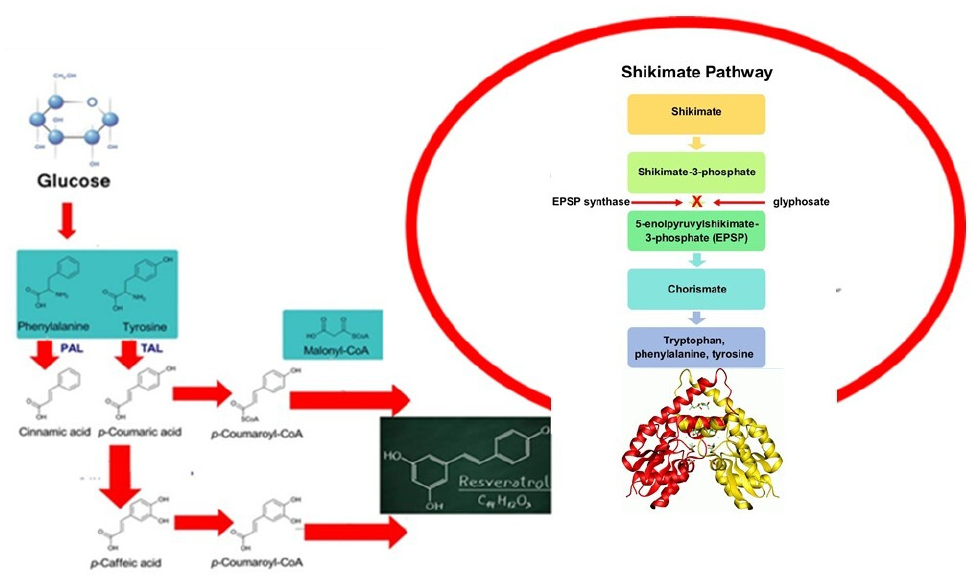
Figure 6. Biochemical pathways of different primary and secondary metabolites identified by non- target and targeted LC-HRMS approaches in the apolar fraction of leaves extracts from basil plants treated with different organic extracts.